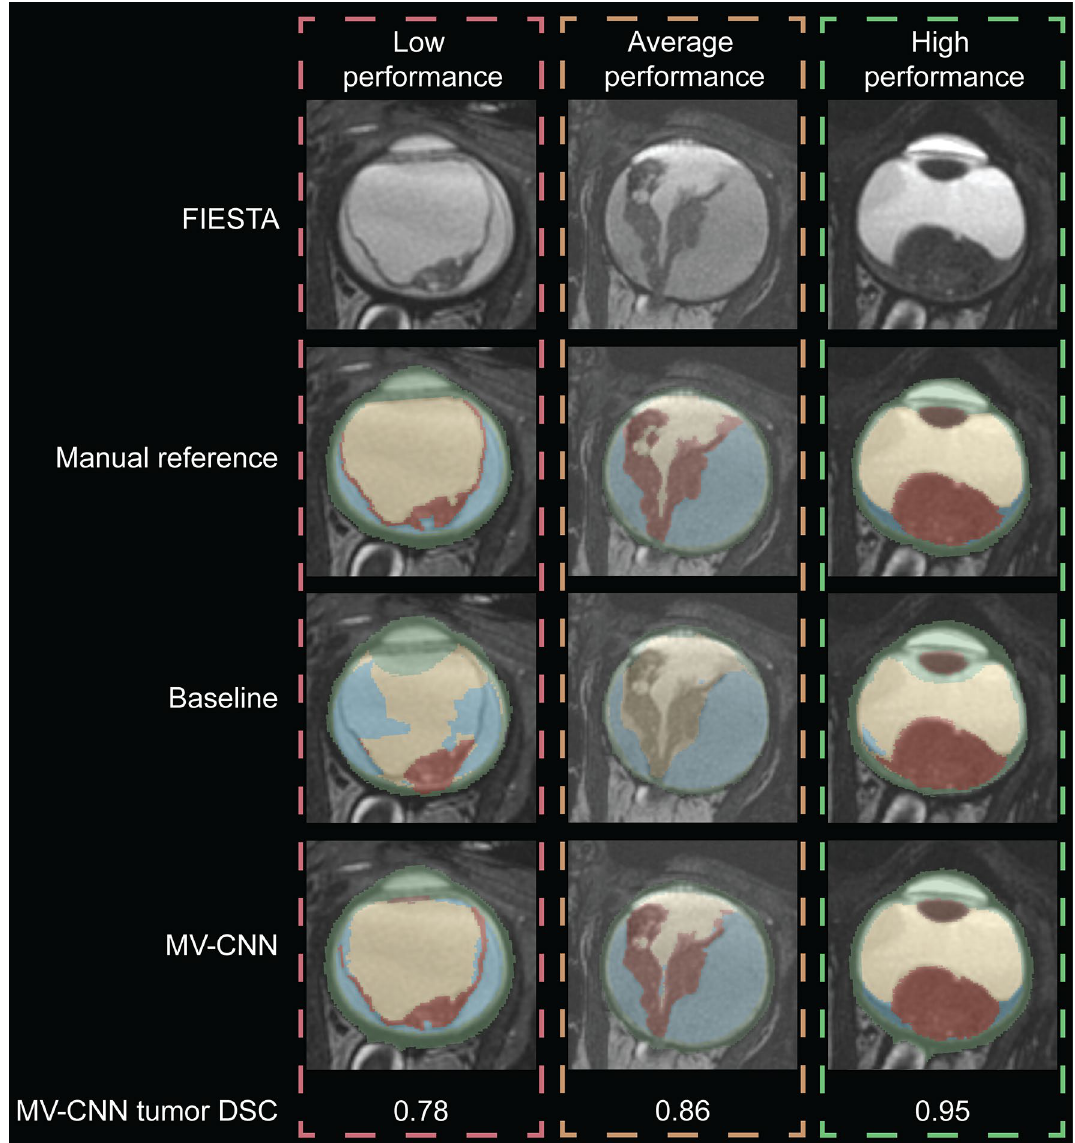
Figure 2. Example segmentations with relatively low (left), average (middle) and high (right) MV-CNN tumor spatial performance. Segmentation color coding: green: sclera, yellow: vitreous humour, brown: lens, blue: retinal detachment, red: tumor. FIESTA Fast Imaging Employing Steady-state Acquisition; DSC Dice’s Similarity Coefficient; MV-CNN multi-view convolutional neural network. Figure was generated with Adobe Illustrator (version 16.0.0; https:// www. adobe. com/ creat ivecl oud.